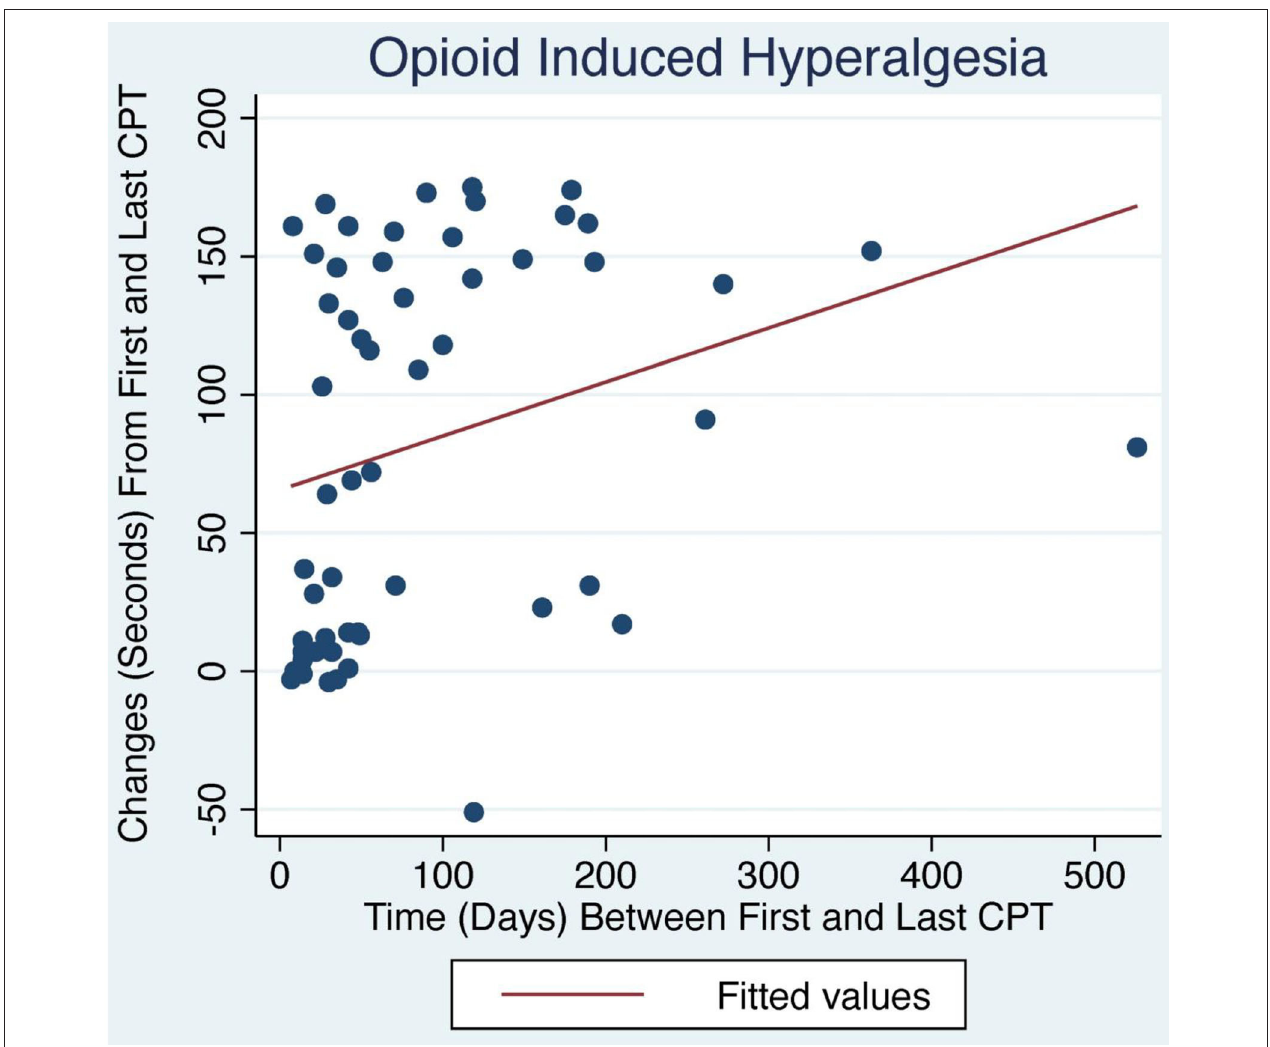
FIGURE 1 | Change in CPT over time with LDN treatment. OIH patients treated with LDN showed a positive relationship between change in CPT and number of days between first and last CPT measurement ( p <